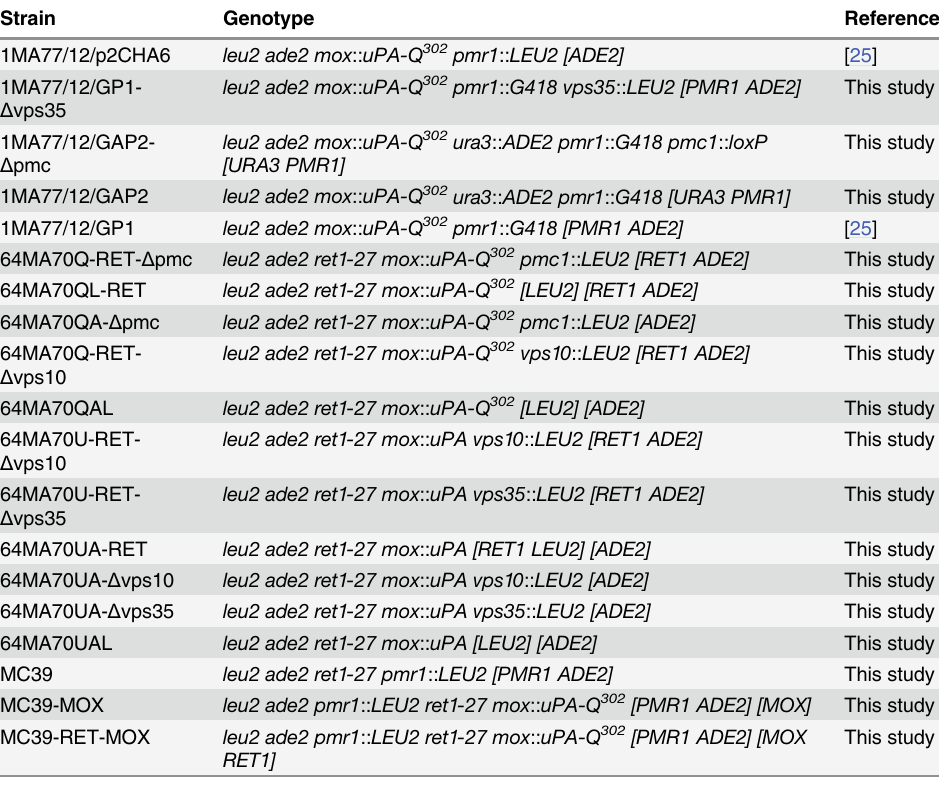
Table 1. H . polymorpha